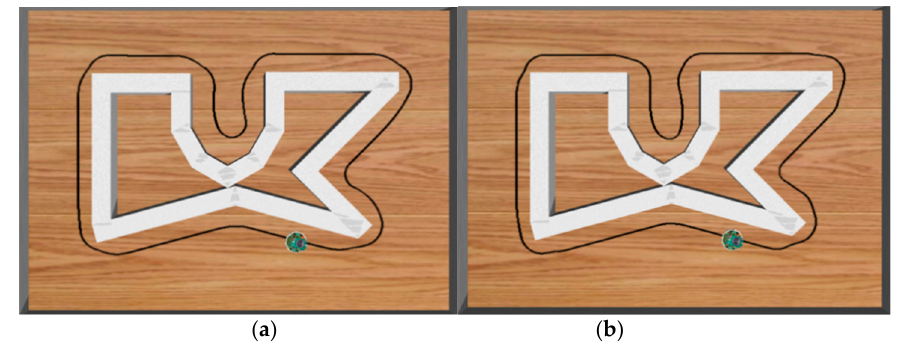
Figure 17. Moving path of the robot in the testing environment 1: ( a ) DGDE-1 and ( b ) DGDE-2.